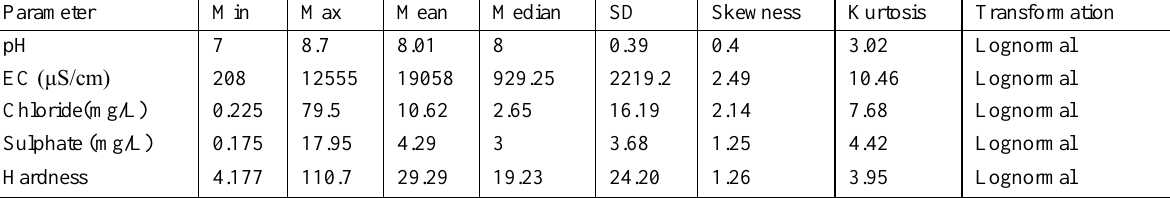
Table2. Statistical evaluation of groundwater quality parameters